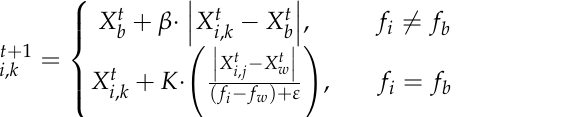
Table 2. Optimization algorithm parameter setting. Optimization Algorithm Set Value GA PSO